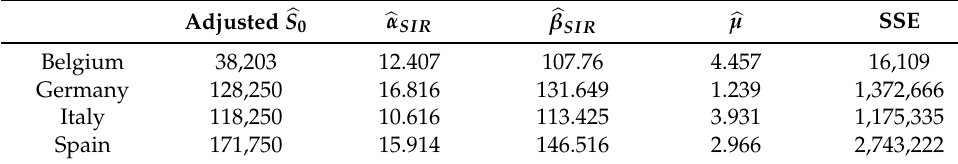
Table 3. Parameter estimates of the SIR